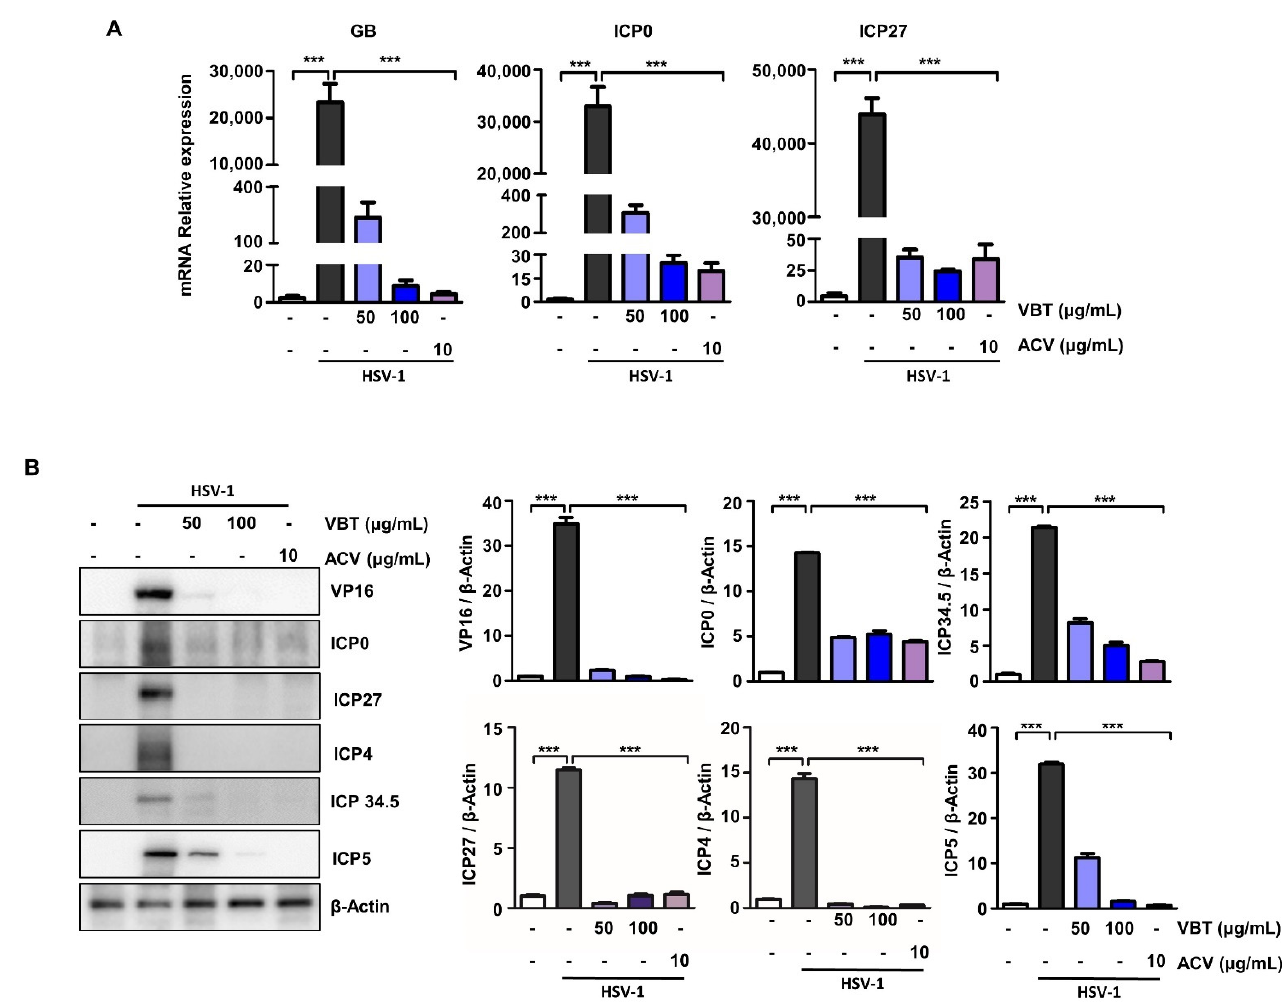
Figure 4. Anti-HSV-1 DNA replication and gene expression of VBT in SK-N-SH cells. The cells were infected with HSV-1 (MOI = 0.1) for 2 h and then replaced with fresh medium. Then, they were treated with VBT (50 µ g/mL and 100 µ g/mL) and ACV (10 µ g/mL), and incubated for 48 h. ( A ) Virus-associated factor mRNA levels were identified by real-time PCR. The expression of these proteins was normalized to that of GAPDH as a relative ratio. ( B ) Virus-associated factor proteins were identified by Western blotting. The expression of these proteins was normalized to that of β -Actin as a relative ratio. *** p < 0.001 vs. HSV-1 treatment